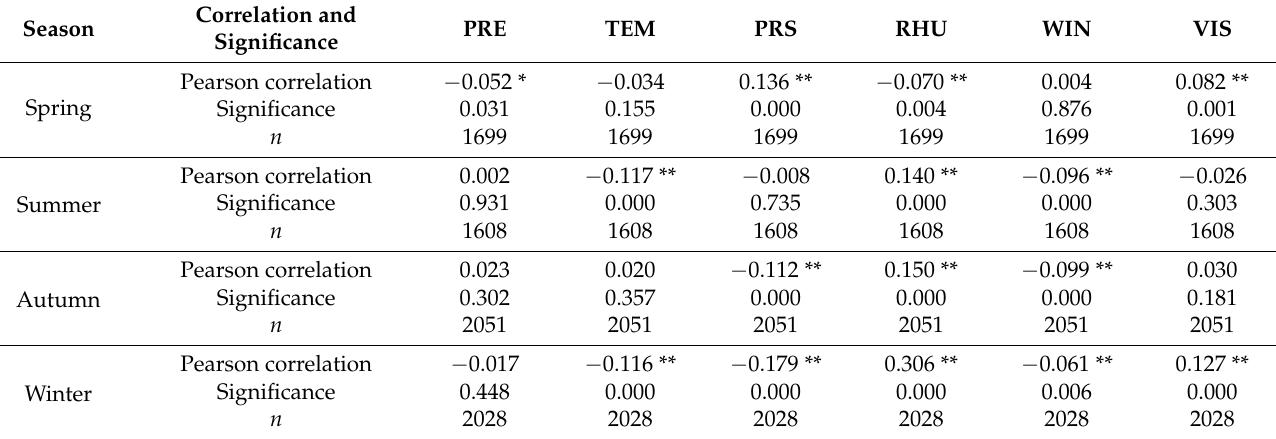
Table 1. Pearson correlation between NAI concentrations and meteorological factors based on raw hourly